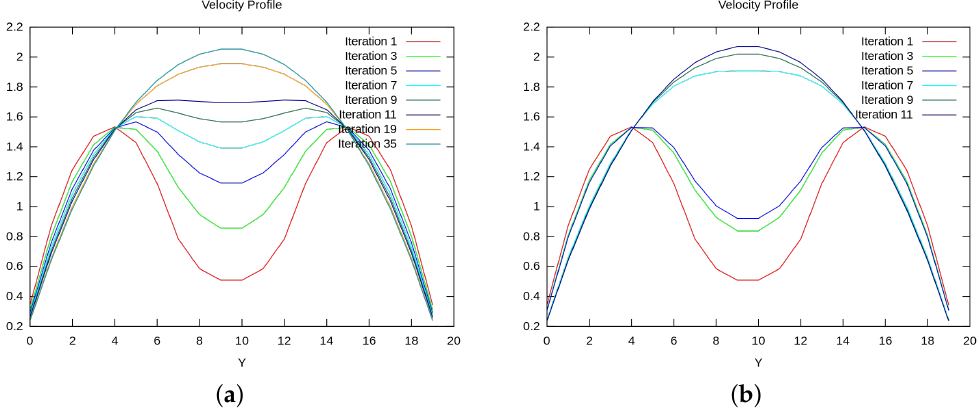
Figure 5. Convergence of the velocity profile at cross-section through empty channel at ( 1.5, y · dx NS ,1.0 ) , y ∈ [ 0,20 ] , towards steady state. ( a ) Simple parallel coupling; ( b ) Anderson accelerated parallel